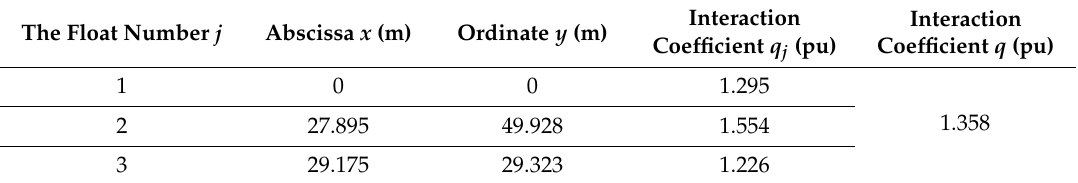
Table 2. Energy capture coefficient of the WEC array ( N = 3).